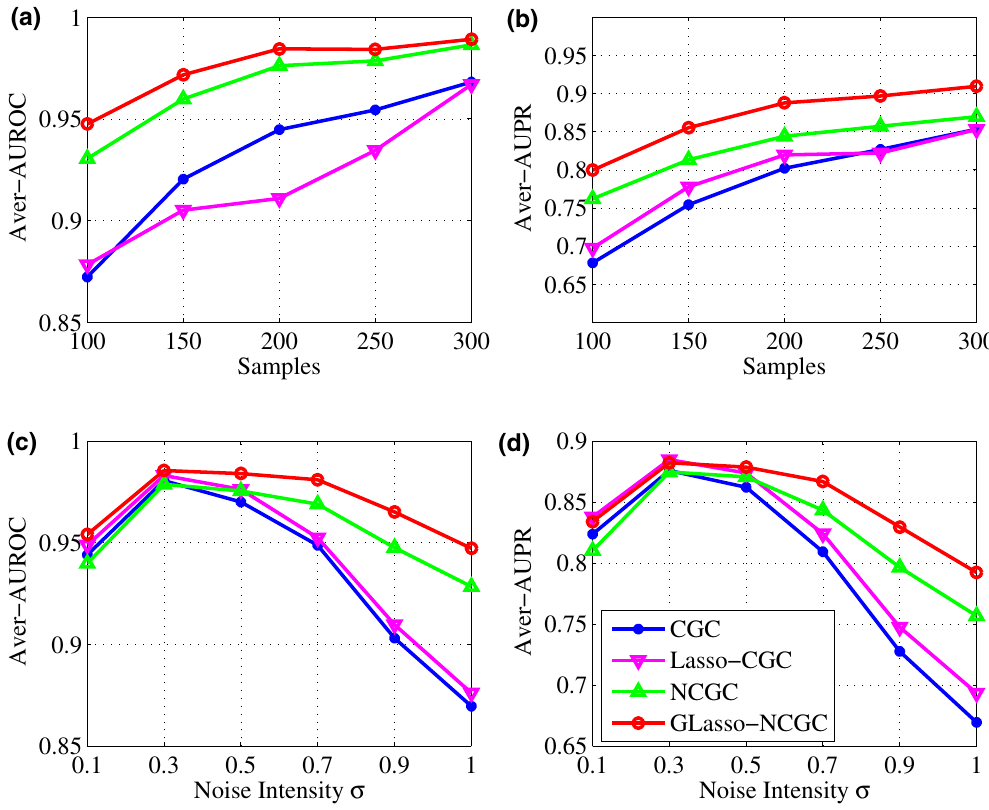
Figure 5. Simulation of nonlinear VAR model. Average AUROC and Average AUPR of different methods acrossing samples (100~300), noise intensities σ (0.1~1) respectively. The values of points in these figures are computed by averaging over 100 independent realizations. ( a , b ) with noise  (0,1) , while ( c , d ) with samples M =